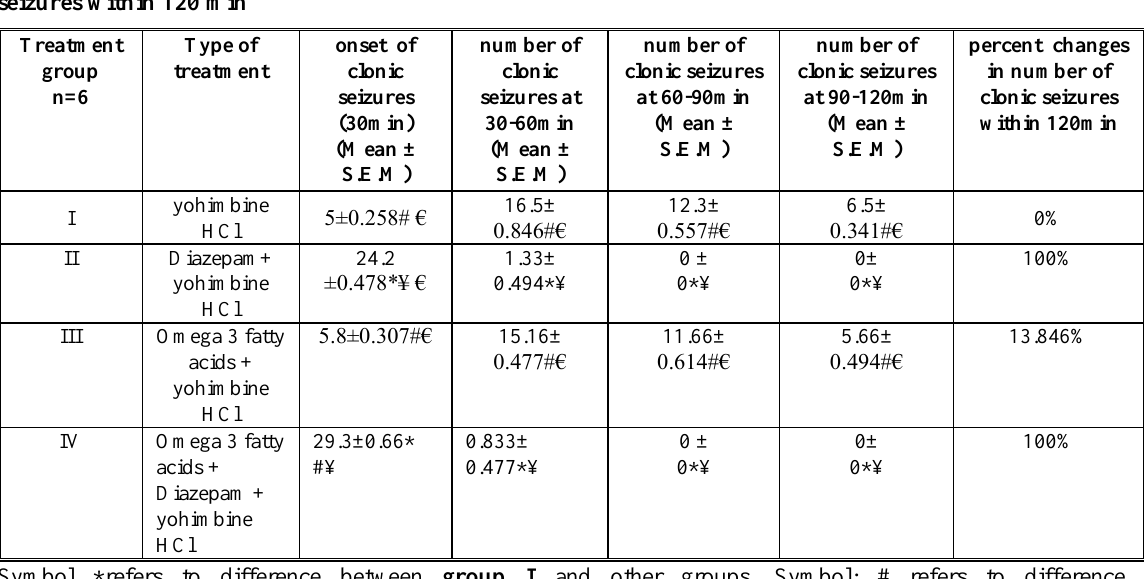
Symbol *refers to difference between group I and other groups. Symbol; # refers to difference between group II and other groups; symbol ¥ refers to difference between group III and other groups; and symbol € refers to difference between group IV and other